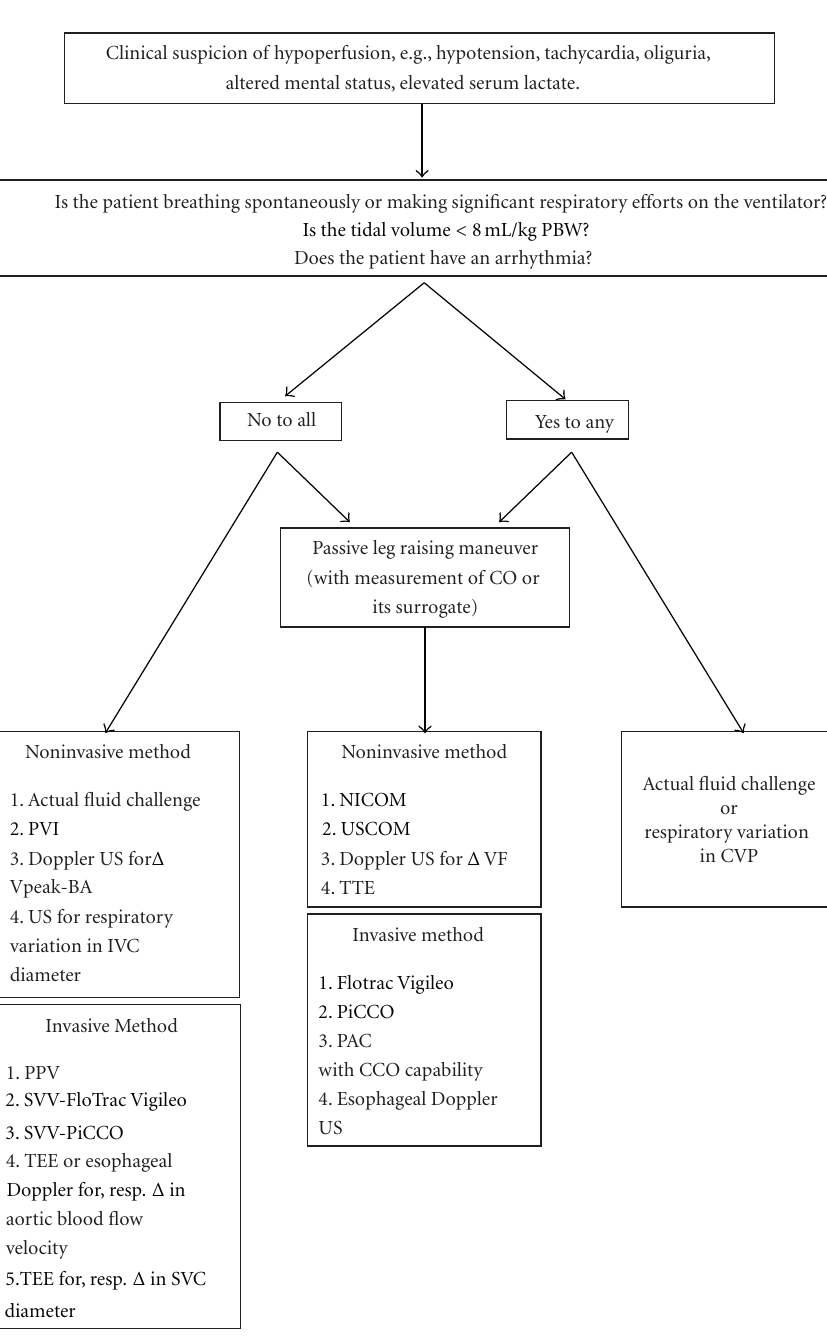
preload responsiveness. An increase in SV (or CO) ≥ of 15% defines preload responsiveness [10]. However, the requirement for measurement of SV (or CO) or alternatively a surrogate, for example, arterial blood flow velocity or